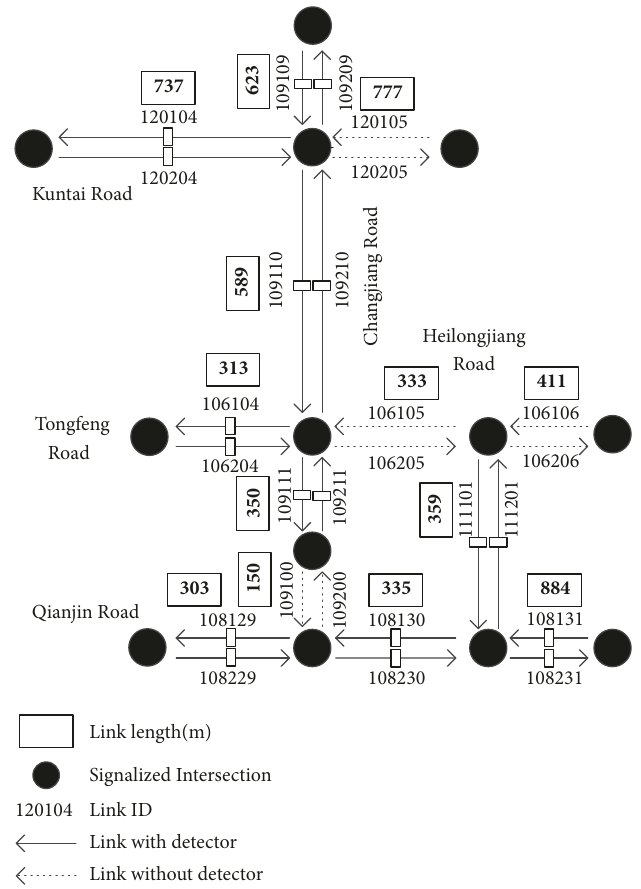
Figure 3: Layout of the test network and detectors in Kunshan City,